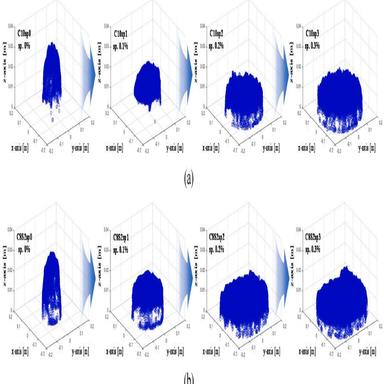
Point cloud of freshly mixed cementitious mixtures after the mini-slump test: (a) C10sp0–3 and (b) C8S2sp0–3 series.